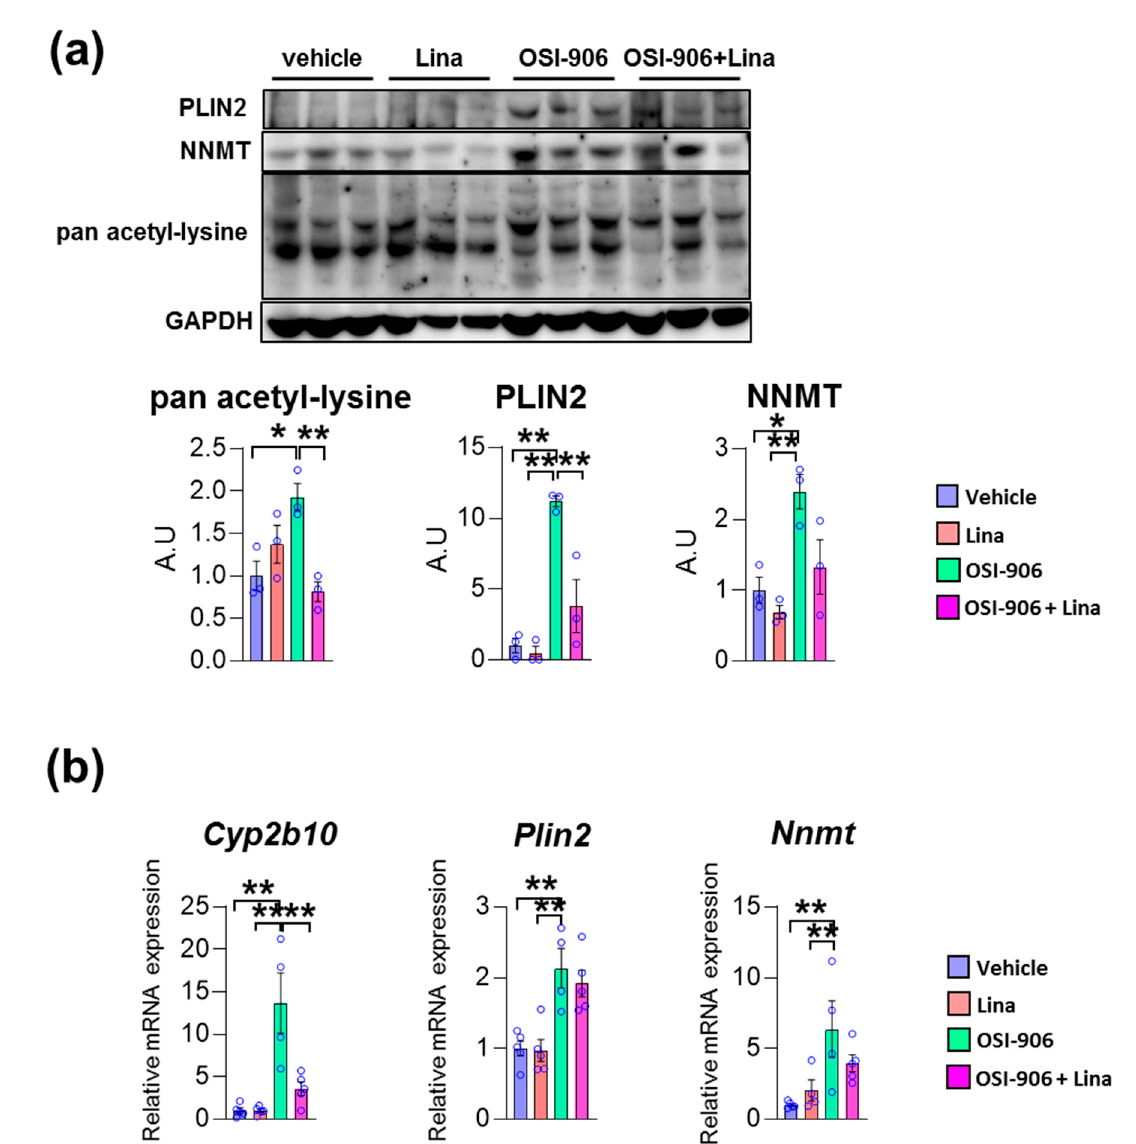
Figure 5. Linagliptin reversed the increased expression of acetylated lysine, perilipin-2, and nicotinamide N-methyltransferase (NNMT) in OSI-906-treated liver. ( a ) Immunoblotting for pan acetyl-lysine, perilipin-2, and NNMT in the liver ( n = 3 per group). Densitometry was plotted in lower graphs. ( b ) Hepatic gene expressions of Cyp2b10, Plin2, and Nnmt on day 7. Data represent the mean ± SEM. * p < 0.05, ** p < 0.01 ( n = 4–5 per group) by ANOVA with an additional Tukey–Kramer post-hoc test.